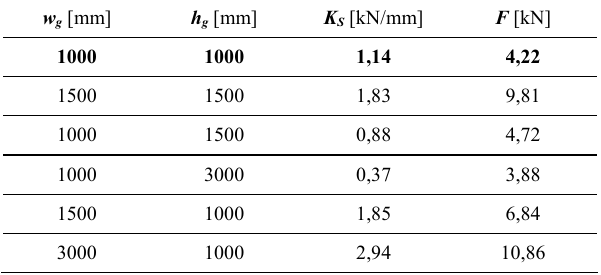
Table 1: In-plane stiffness and horizontal in-plane load obtained for different panel dimensions.